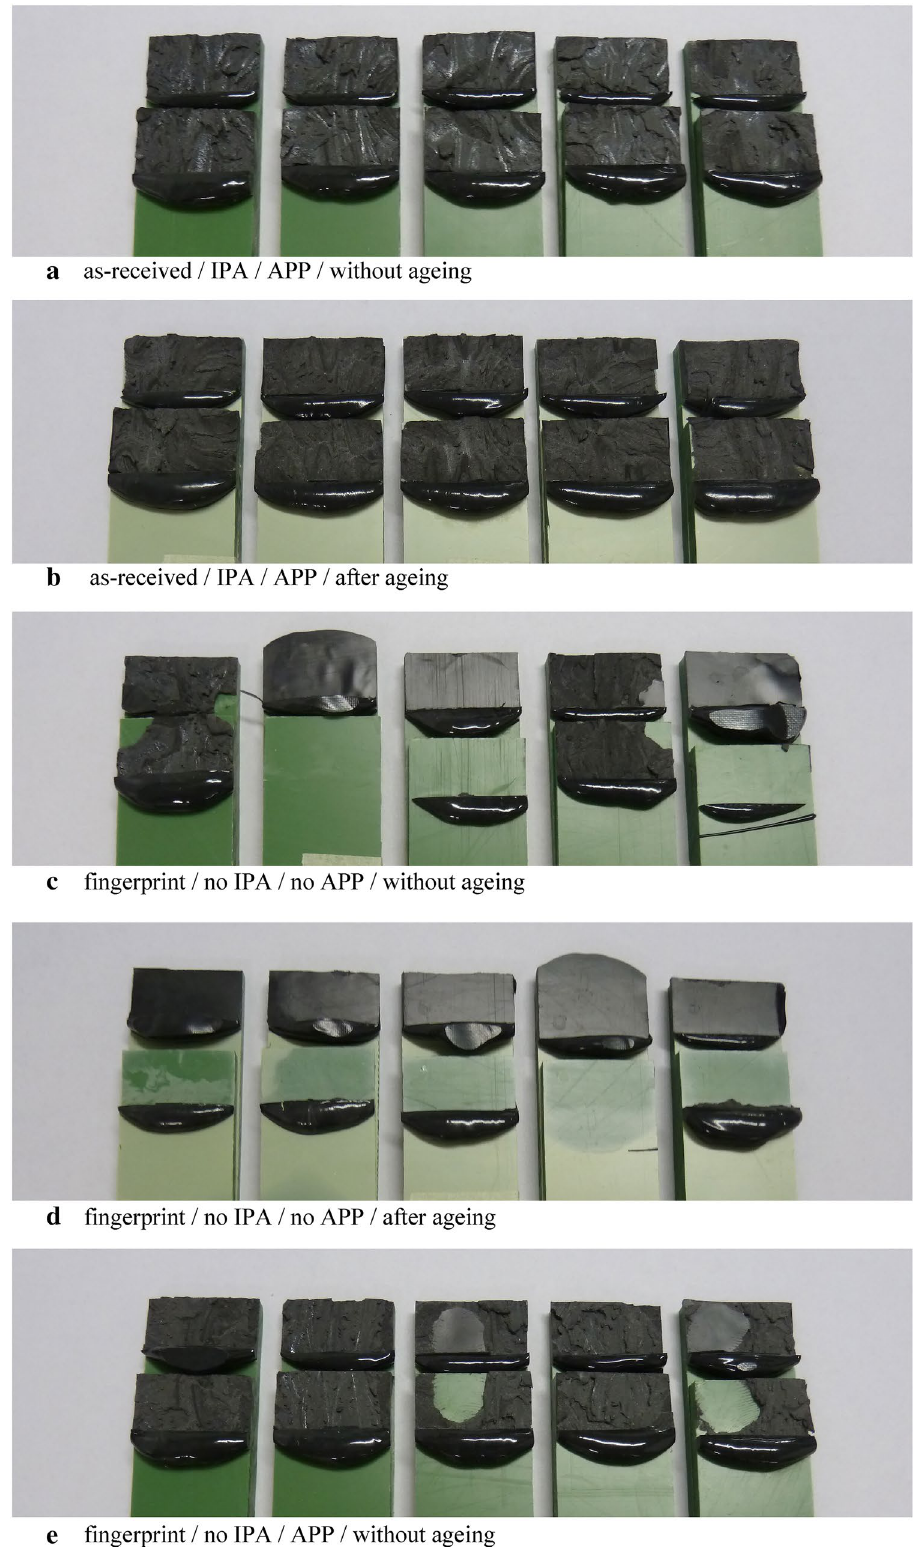
Fig. 4 Set of photographical images of destructively tested adhesive joints based on green ABS-PMMA adherends and following distinct pretreat- ment and ageing procedures: as-received/IPA/APP adherends without and after ageing a and b , fingerprint/no IPA/no APP adherends without and after ageing c and d , fingerprint/ no IPA/APP adherends without and after ageing ( e and f ), fingerprint/IPA/no APP adher- ends without and after ageing g and h , and fingerprint/IPA/ APP adherends without and after ageing i and